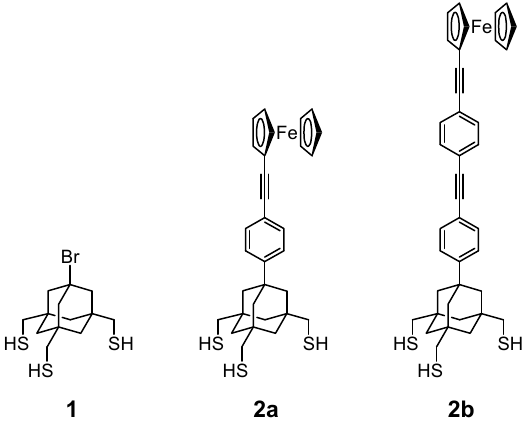
Figure 1. Tripod-shaped trithiols with an adamantane core.